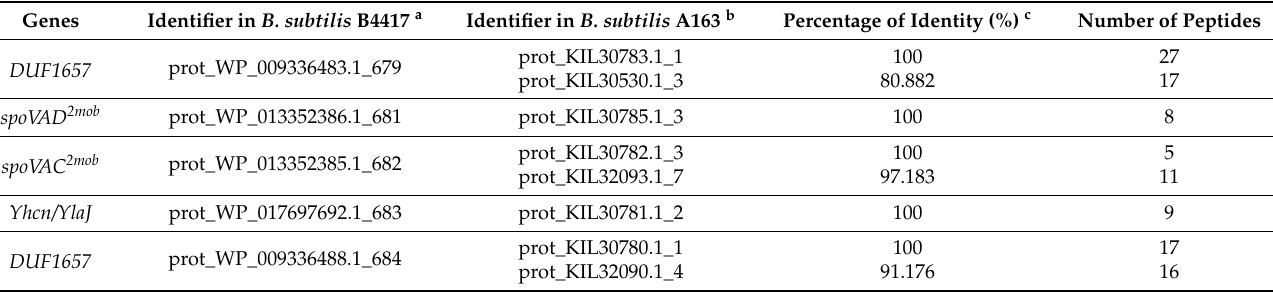
Table 1. spoVA 2mob proteins identified in B. subtilis A163